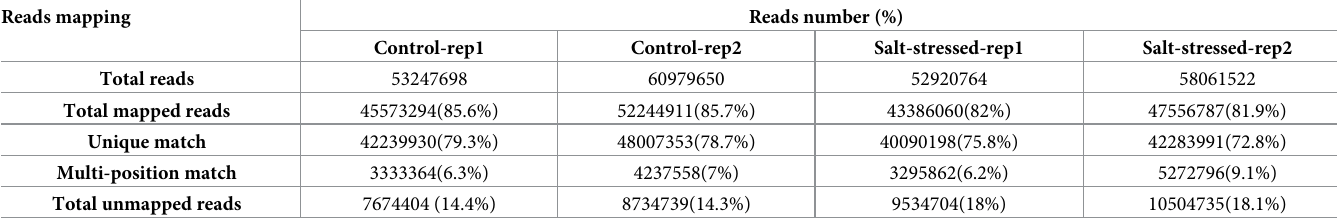
Table 2. Results of mapping reads to the reference